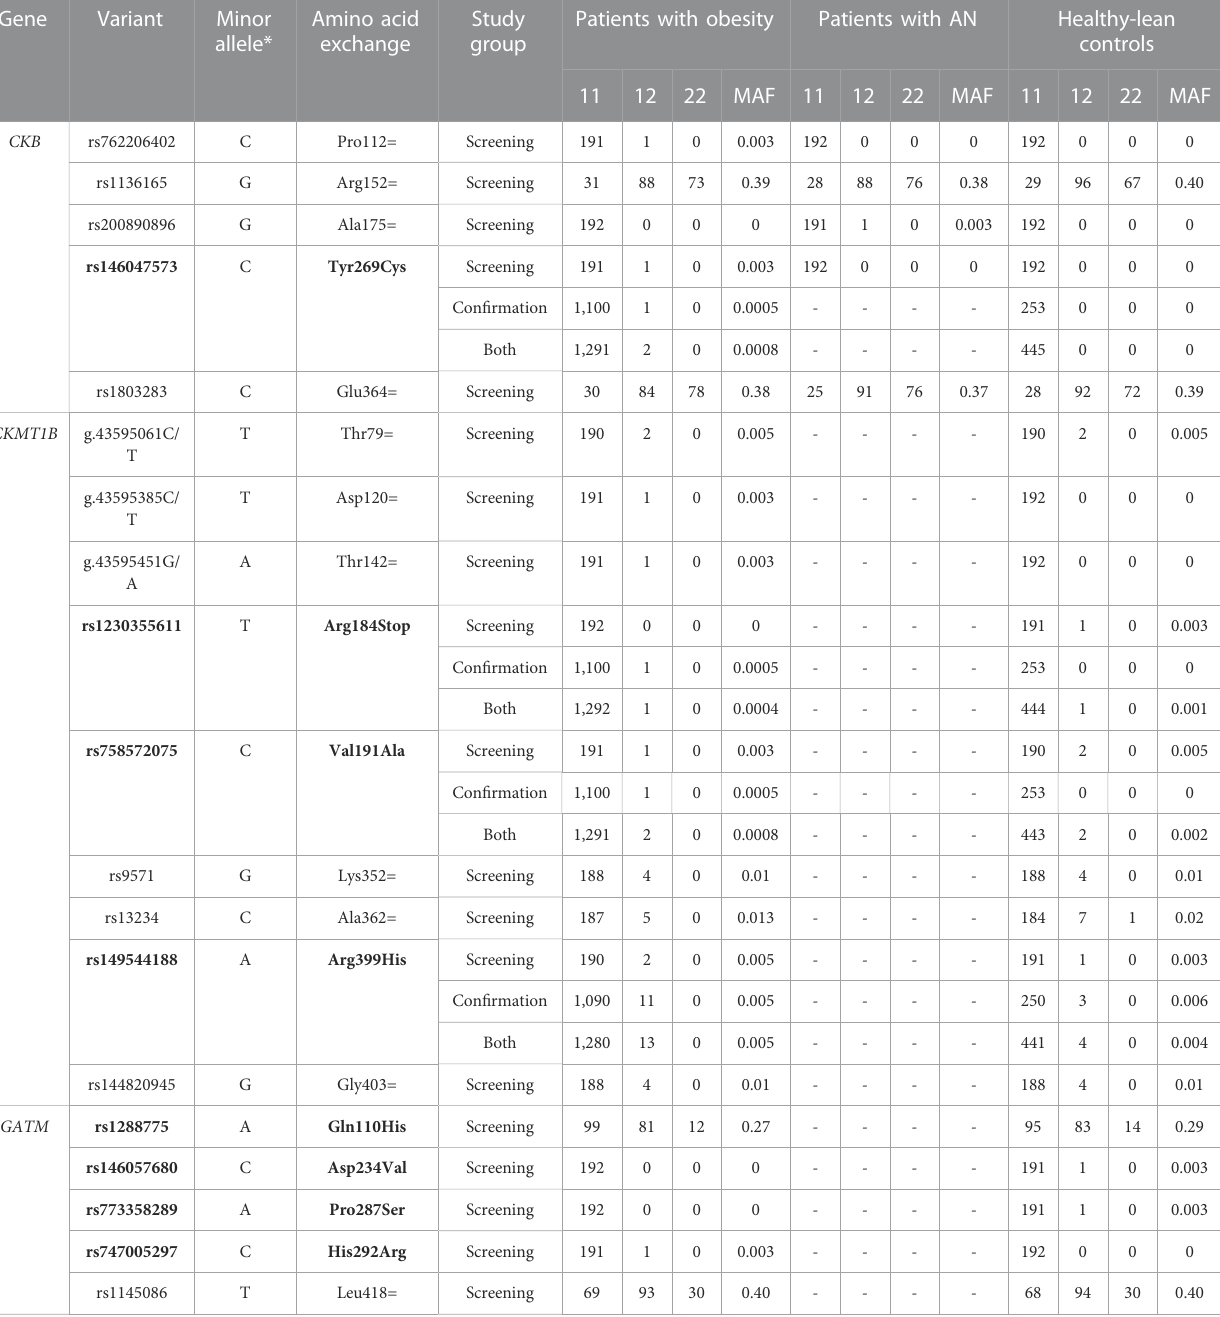
TABLE3Identi fi edgeneticvariants intheinvestigatedstudygroups.Theresults include thescreeninggroupsof192childrenandadolescents withsevereobesity as well as 192 patients with AN and 192 healthy-lean controls. The sample sizes may vary if the variant was genotyped in an additional con fi rmation group consisting of 781 trios with severe obesity, 320 independent children and adolescents with severe obesity, and 253 healthy-lean control samples (see Table 2). Non-synonymous variants are shown in bold. The represented minor allele is based on the forward strand (*). 11: Homozygous wild type; 12: heterozygous, 22: homozygous alternative allele. MAF: minor allele